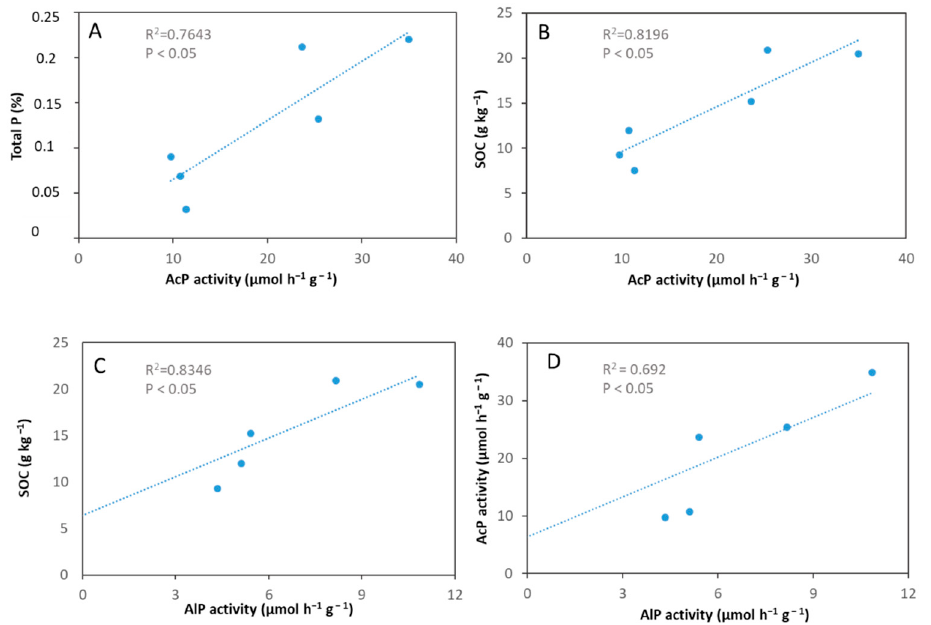
Figure 5. Relationships between the total P content, SOC content, AcP and AlP activity in soils CL01, CL02, CL03, VL01, VL02, VL03. AlP activity of sample CL03 was under detection limit. ( A ) Correlation between total P content and acid phosphatase activity. ( B ) Correlation of SOC content with acid phosphatase activity. ( C ) Correlation between SOC and alkaline phosphatase activity. ( D ) Correlation between acid phosphatase activity and alkaline phosphatase activity.